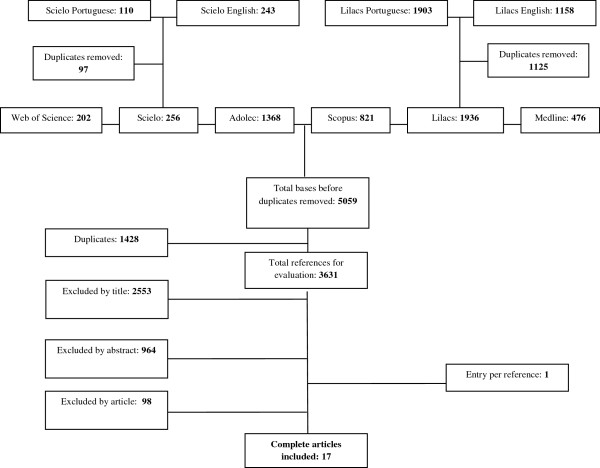
Study flowchart.